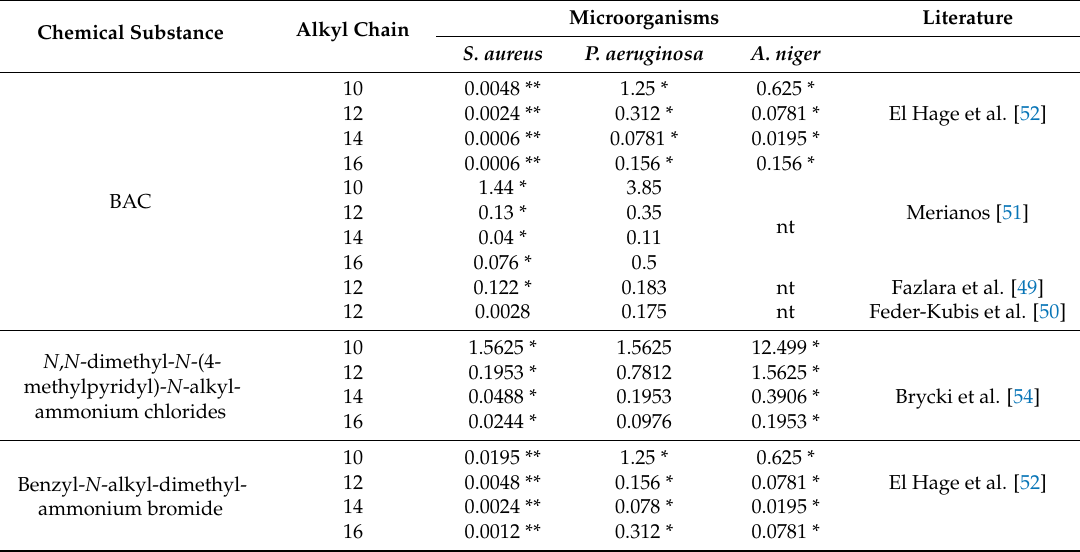
Table 5. MIC values for benzalkonium chloride derivatives containing 10–16 carbon atoms in aliphatic chains—literature data